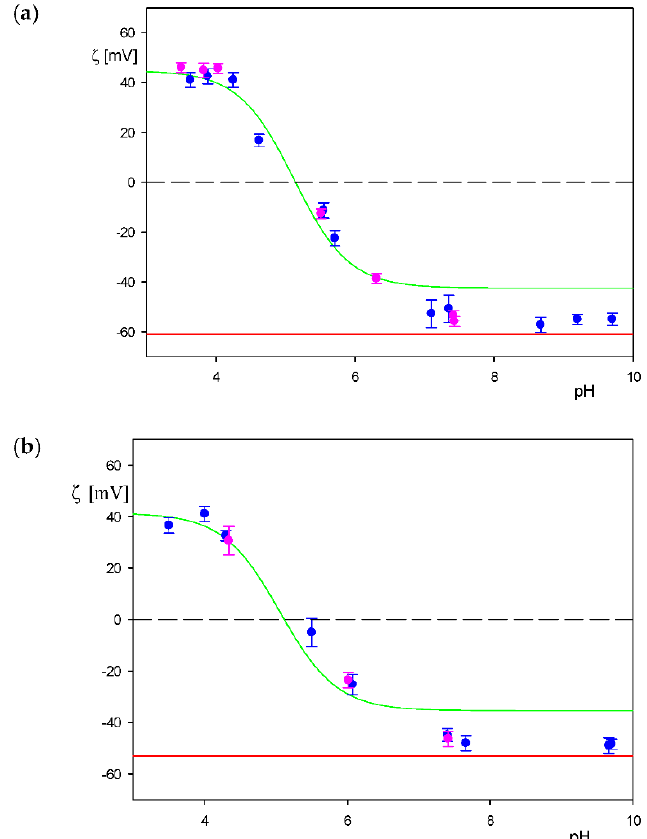
Figure 8. Dependencies of the zeta potential on pH derived from the LDV measurements: ( a ) 1 mM NaCl, ( b ) 10 mM NaCl. The green lines show the bulk zeta potential of HSA molecules, the red lines show the bulk zeta potential of the bare polymer particles and ( ● , ● ) represents experimental data for the particles with the HSA corona (the coverage of 0.80 mg m − 2 ).